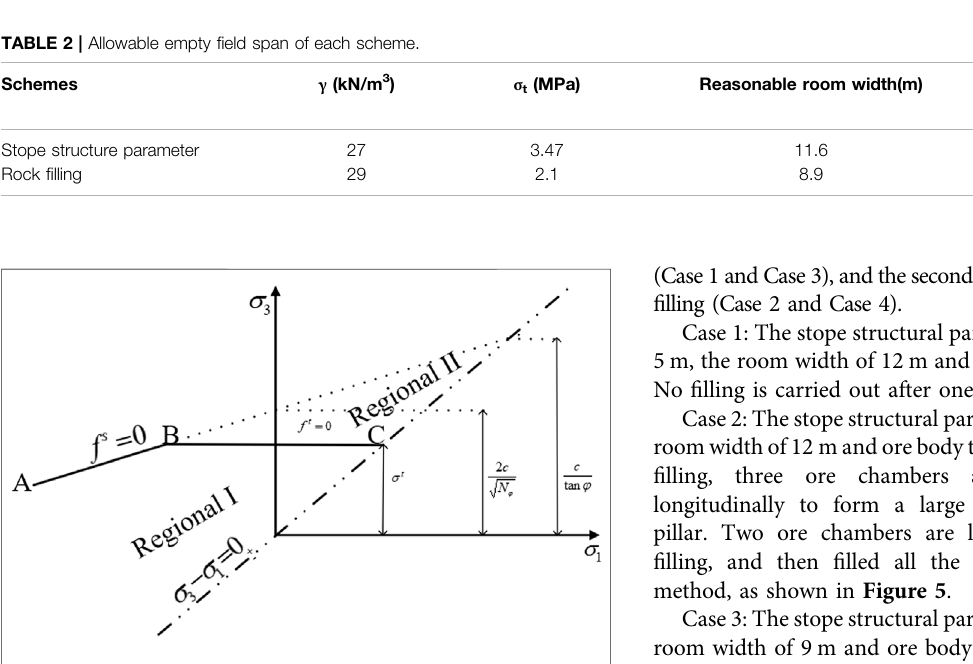
FIGURE 4 | Mohr-Coulomb strength criterion in